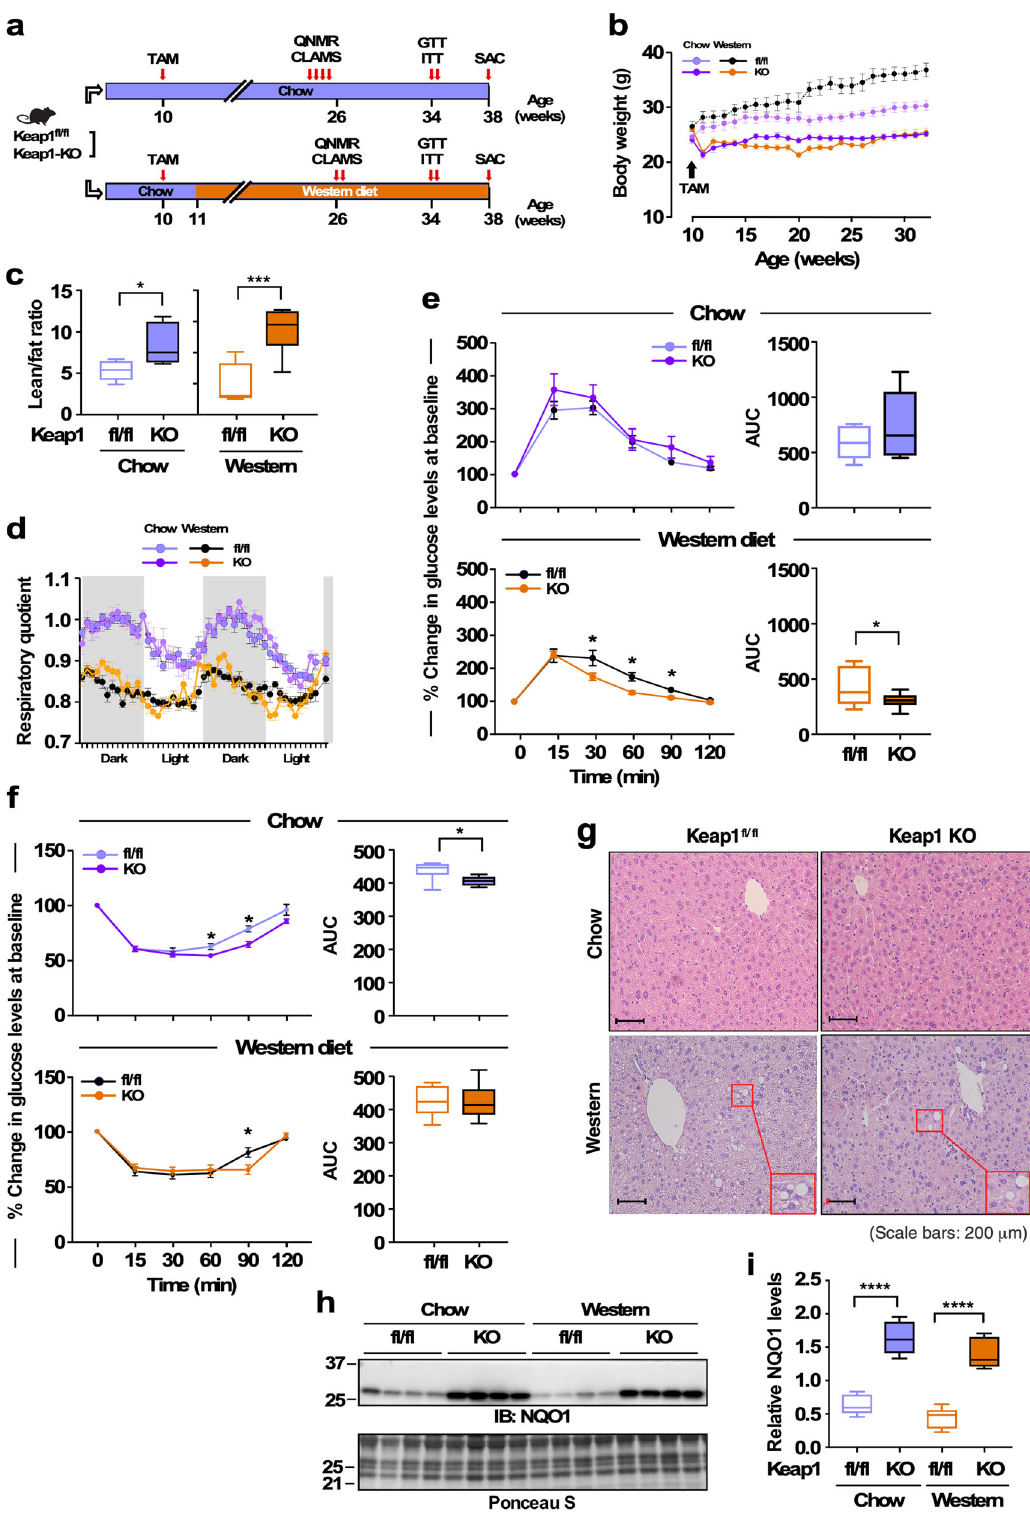
NQO1 overexpression improves glucose homeostasis and insulin sensitivity in Tg mice on HFD To test the hypothesis that upregulation of NQO1 ameliorates diet-induced imbalance in metabolic homeostasis, we generated a